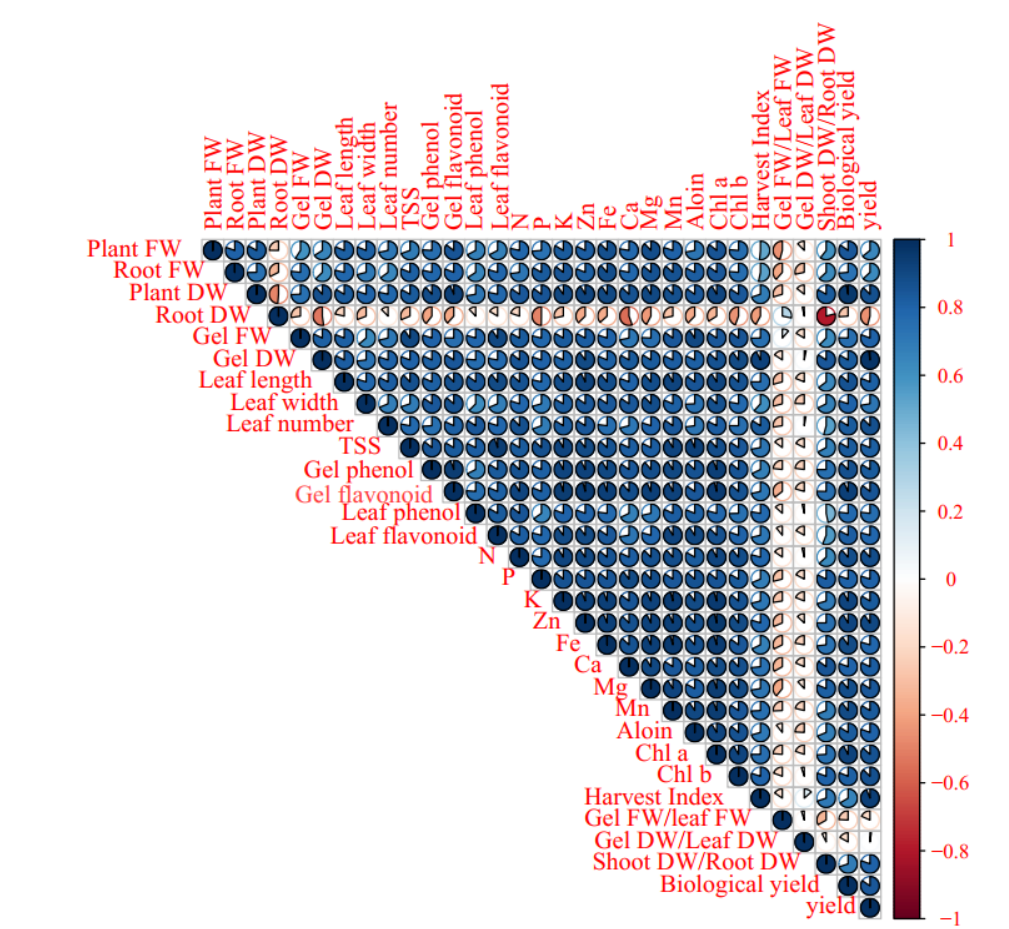
Figure 7. Pearson’s correlation heat map of soil-based animal manure use × foliar applications (distilled water, salicylic acid, cerium oxide nanoparticles, and CeO 2 : SA-nanoparticles) on the growth, physiological responses, and elemental content of Aloe vera L. plants. FW and DW refer to fresh and dry weight, respectively.